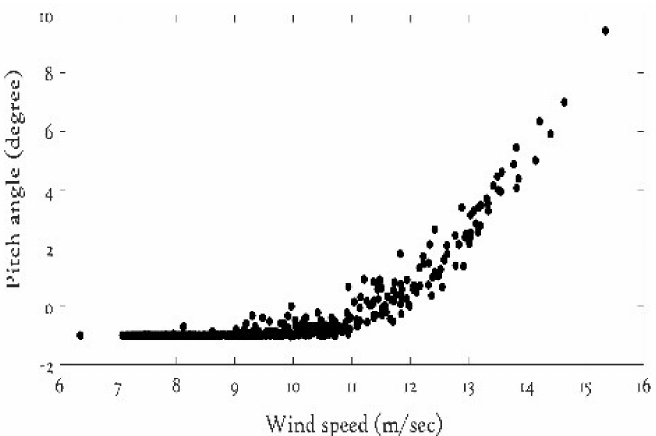
Figure 6. Filtered blade pitch curve.